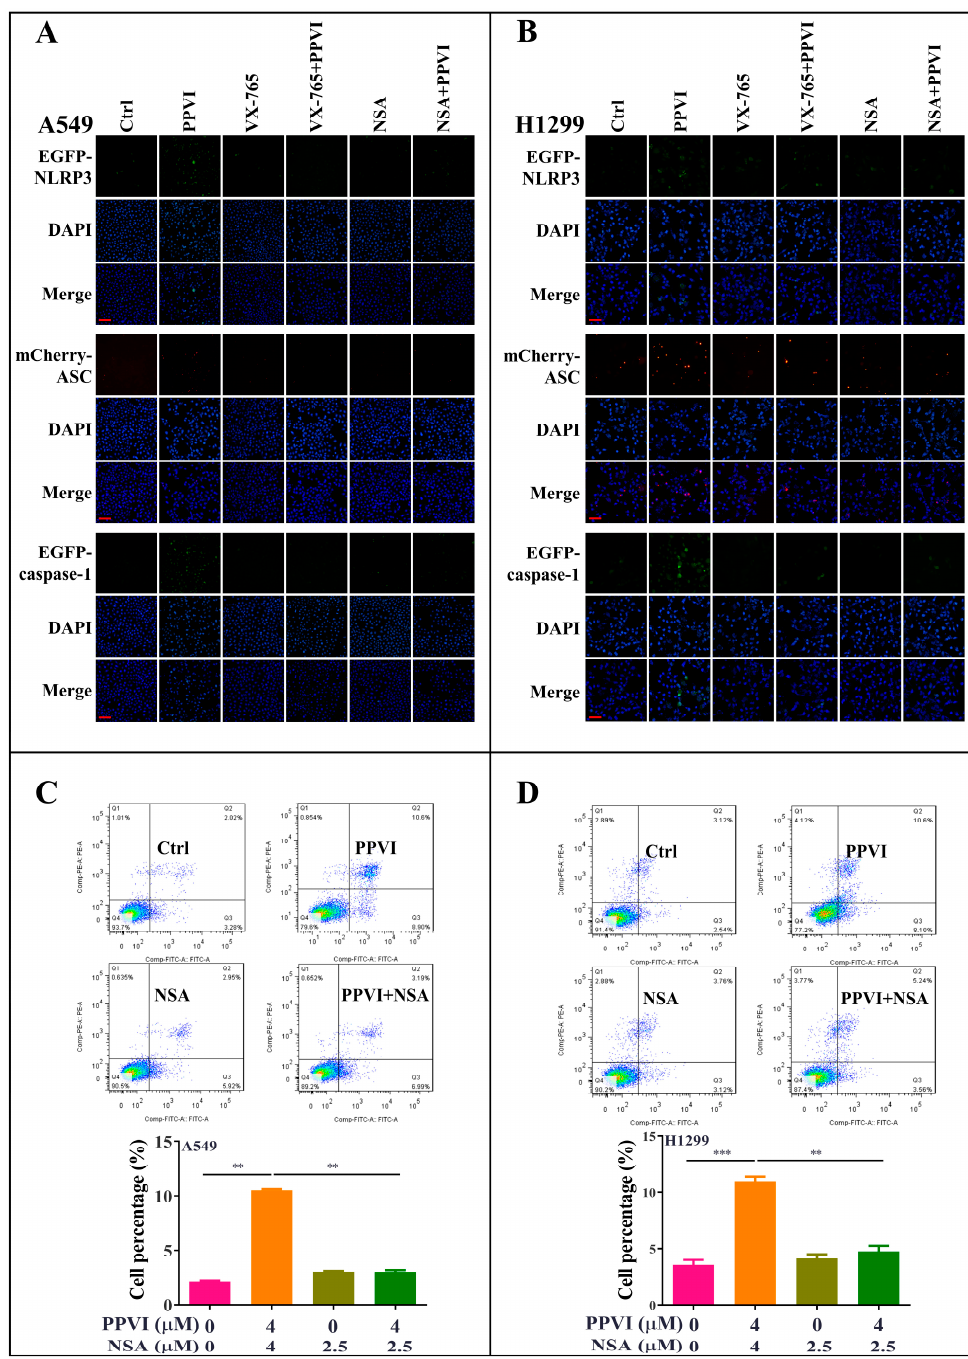
Figure 6. PPVI VX-765 and NSA reversed the activation of the NLRP3 inflammasome of PPVI-treated A549 and H1299 cells. A549 cells ( A ) and H1299 cells ( B ), transiently transfected with EGFP-N1-NLRP3, mCherry-C1-ASC and EGFP-N1-caspase-1 plasmids for 24 h, were treated with PPVI or co-treated with VX-765 or NSA and PPVI, as per the indicated concentration, for another 24 h. After treatment, the cells were fixed with 4% PFA, and the representative images were captured using the fluorescence microscope. Magnification: 20×. Scale bar: 50 µm. Pyroptotic cells of A549 cells ( C ) and H1299 cells ( D ) treated with PPVI or co-treated with NSA and PPVI, as indicated. Treatment concentrations were measured by flow cytometry using an annexin V-FITC / PI apoptotic detecting kit. Annexin V + / PI + indicated the pyroptotic cells. Bar chart indicates the percentage of pyroptotic cells and living cells; bars, S.D. ** p ≤ 0.01, *** p ≤